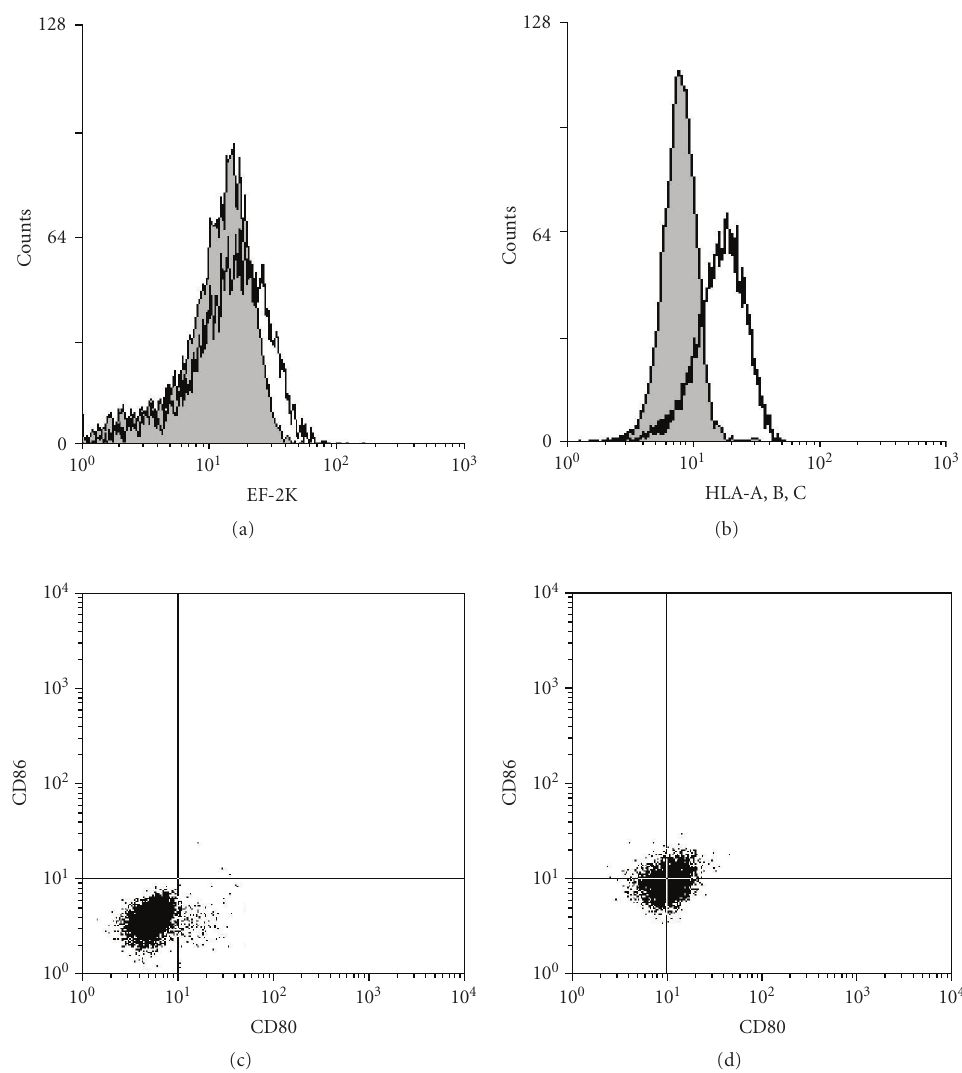
Figure 5: Flow cytometric analyses of target cells . (a) Typical analysis of EF-2K expression on HGC-27 cells is shown. The shadowed histogram indicates the EF-2K detected by GU sera in nontreated HGC-27 cells. And the bold histogram indicates the EF-2K detected by GU sera in heat-stressed HGC-27 cells. (b) Typical analysis of MHC class I molecule expression on HGC-27 cells is shown. The shadowed histogram indicates MHC class I molecules detected by PE-Cy5 conjugated mouse antihuman HLA-A, B, C antibody in nontreated HGC-27 cells and the bold histogram indicates MHC class I molecules detected by PE-Cy5 conjugated mouse antihuman HLA-A, B, C antibody in heat- stressed HGC-27 cells. The costimulatory molecules detected by FITC conjugated mouse antihuman CD80 antibody and PE conjugated mouse antihuman CD86 antibody on nontreated HGC-27 cells are shown in (c) and those of heat-stressed HGC-27 cells in (d). The heat stress enhanced the expression of EF-2K, MHC class I molecules, and costimulatory molecules on HGC-27 cells (target